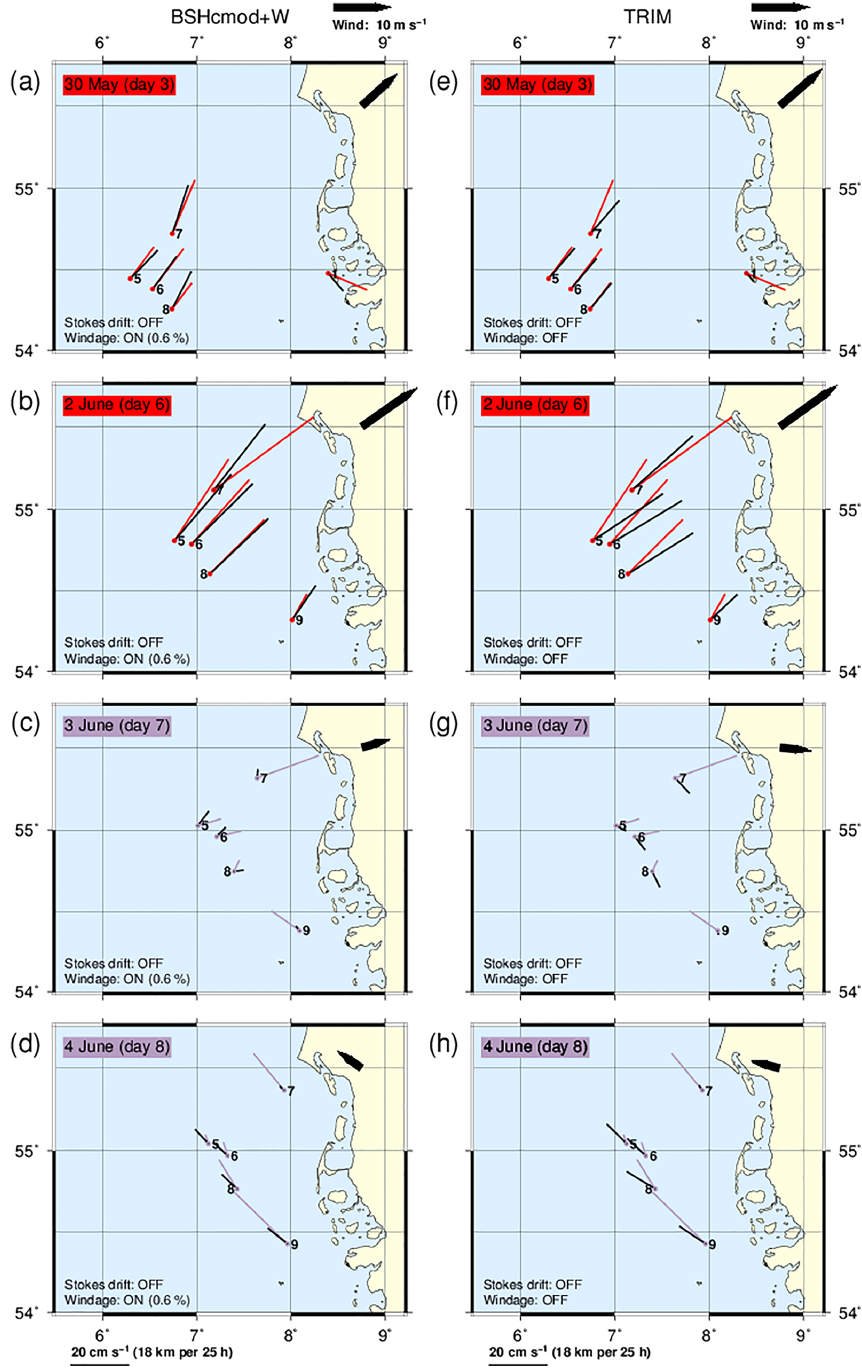
Figure 7. Observed 25h drift paths (coloured in agreement with Table S1) are contrasted against concurrent simulations (black) based on BSHcmod + W (a–d) or TRIM (e–h) . For 4 selected days, panels combine all drifters observed at the time of the plot. All drift distances were converted into 25h mean drift velocities. Note that the length scales shown do not correspond with the spatial scale of the geographic map. Vectors in each panel’s top right corner indicate the mean wind velocity vector at 55 ◦ N and 7 ◦ E derived from the respective atmospheric model